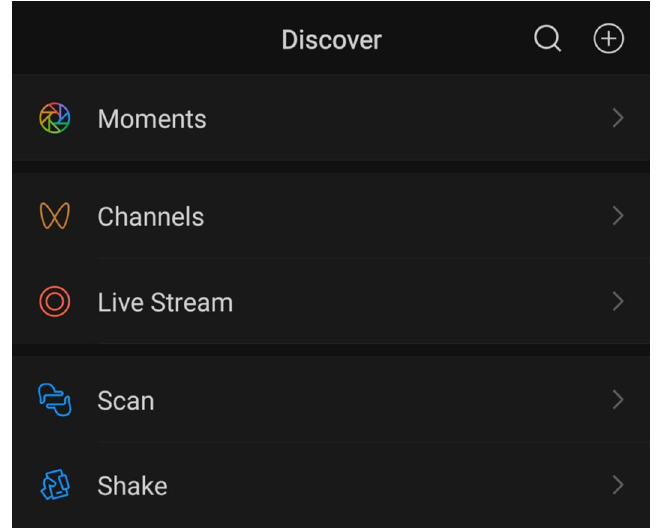
Fig. 15 WeChat moments are found on the discover